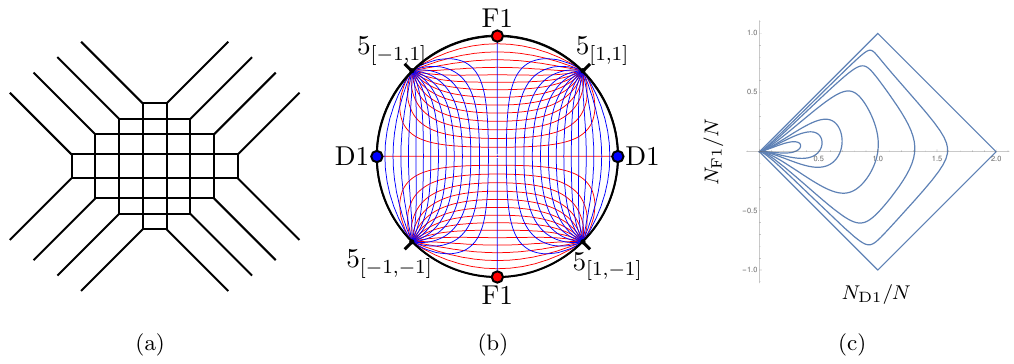
Figure 7 . Left: brane web realizing the gauge theory (2.47). Center: X N supergravity solution on the disc, with the 5-brane poles and some string embeddings. Along the red/blue curves the D3-brane has constant F1/D1 charge. Right: ( N D1 ; N F1 ) curves, from outer to inner curve for (cid:8) (cid:9) Im( w ) 2 10 (cid:0) 6 ; 1 ; 1 ; 1 ; 2 ; 3 ; 1 . The Im( w ) = 10 (cid:0) 6 curve traces the boundary of the disc in 20 10 5 5 5 (cid:12)gure 7(b). The F1/D1 charge identi(cid:12)es the vertical/horizontal coordinate of the face of the